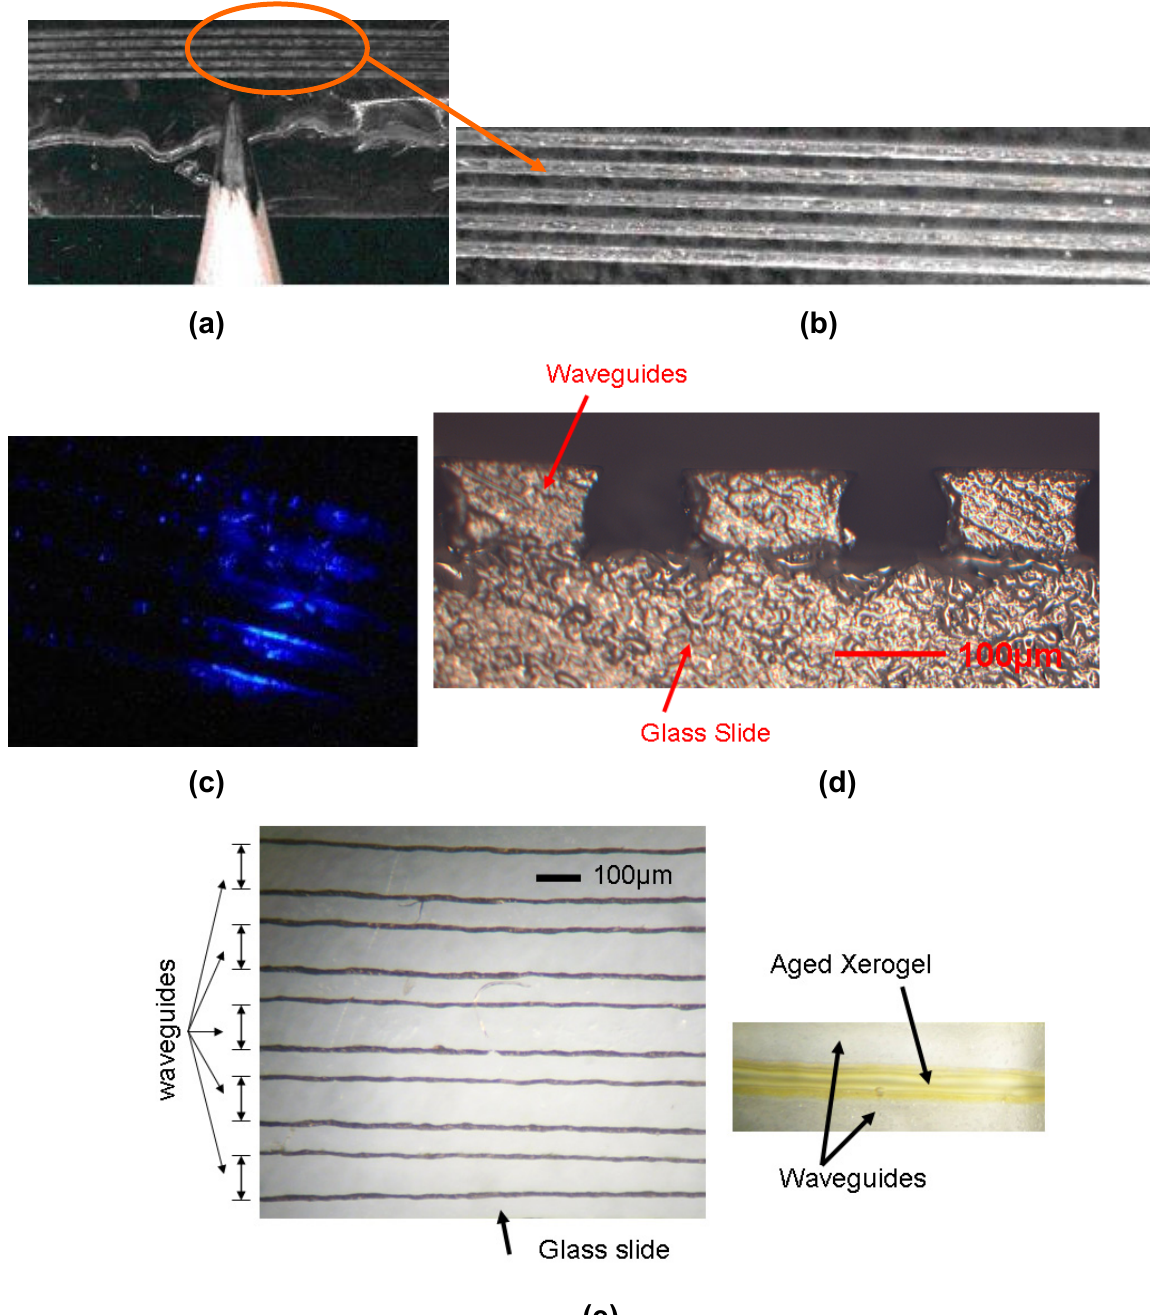
Figure 5. Fabricated epoxy waveguides using the direct-dispense deposition technique. (a) Shows the top-view of the fabricated 100 μ m wide ridge waveguides spaced 75 μ m apart with a pencil tip as reference; (b) Magnified top-view of a selected portion of the waveguides; (c) Multimode epoxy waveguides which conduct light from a blue ( λ nm) LED; (d) Cross-sectional view of the waveguides; (e) Magnified top-view of the transparent waveguides under intense optical illumination which shows the straightness and reproducibility of the structures. Figure (e) also shows the deposited xerogel after